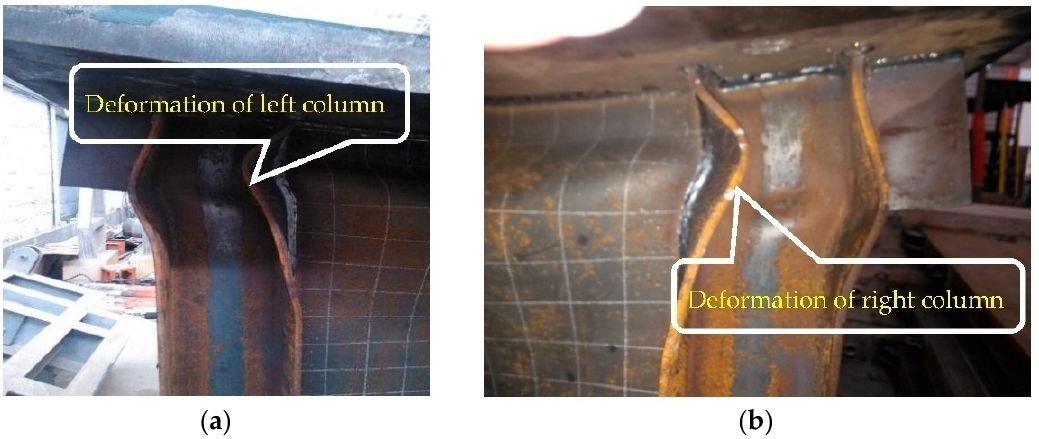
Figure 33. Deformation of column flange for specimen 2: ( a ) Left column flange; ( b ) Right column flange.